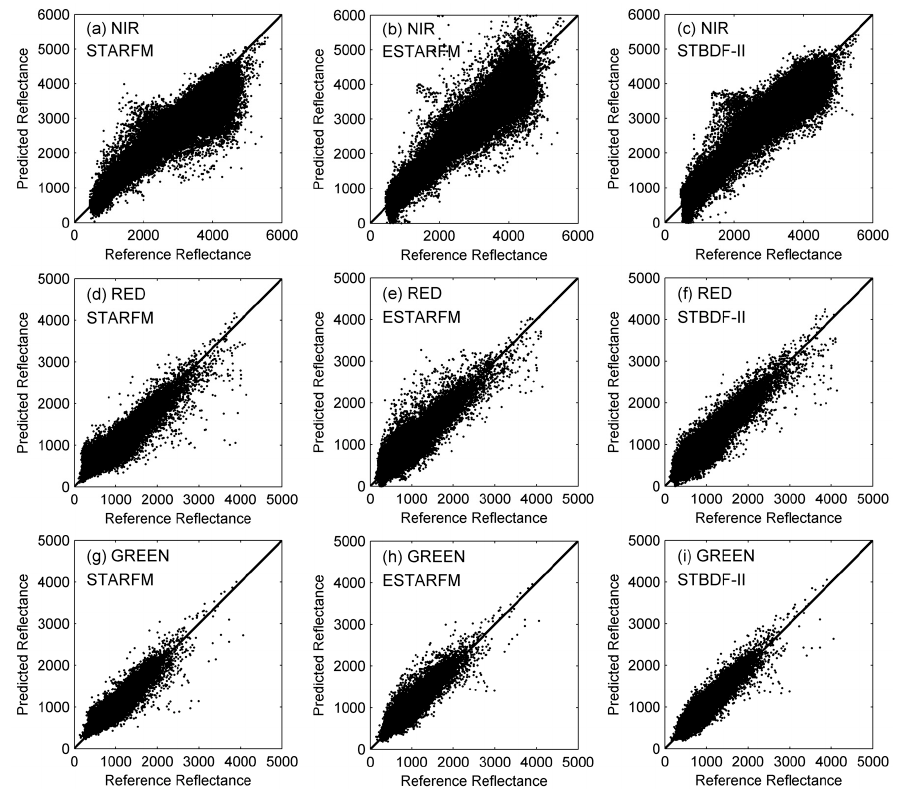
marked in Figure 10a corresponding to the images in Figure 10a–d. in Figure 10a corresponding to the images in Figure 10a–d. Remote Sens. 2017 , 9 , 1310